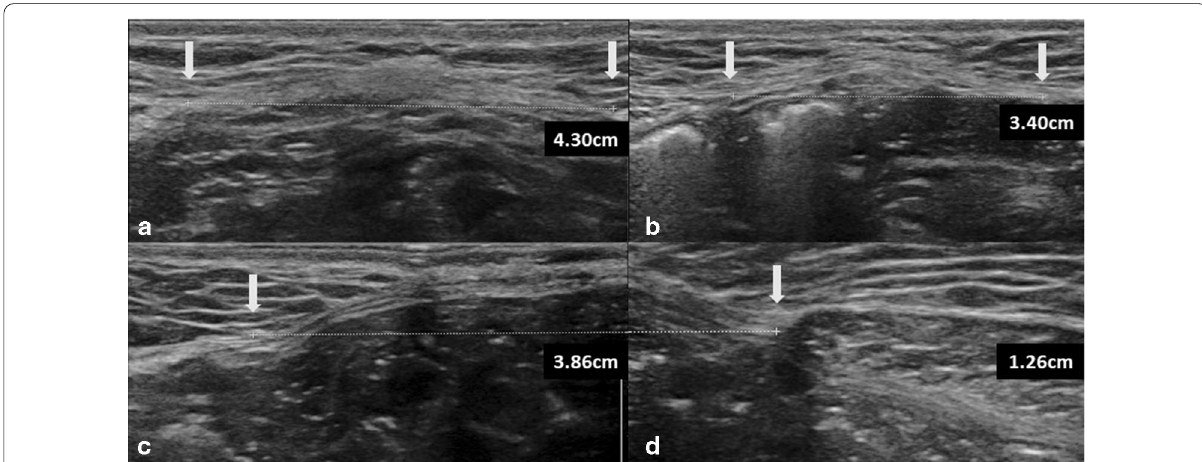
Fig. 2 Forty-year-old woman with one previous pregnancy. Diastasis (calipers) is present at the level of M2 (above the umbilicus, a 4.30 cm), at the level of M4 (below the umbilicus, b 3.40 cm). At the level of M2 (umbilicus), measurements were combined with two separate calipers ( c 3.86 cm, d 1.26 cm). White arrows pointed to the locations of calipers